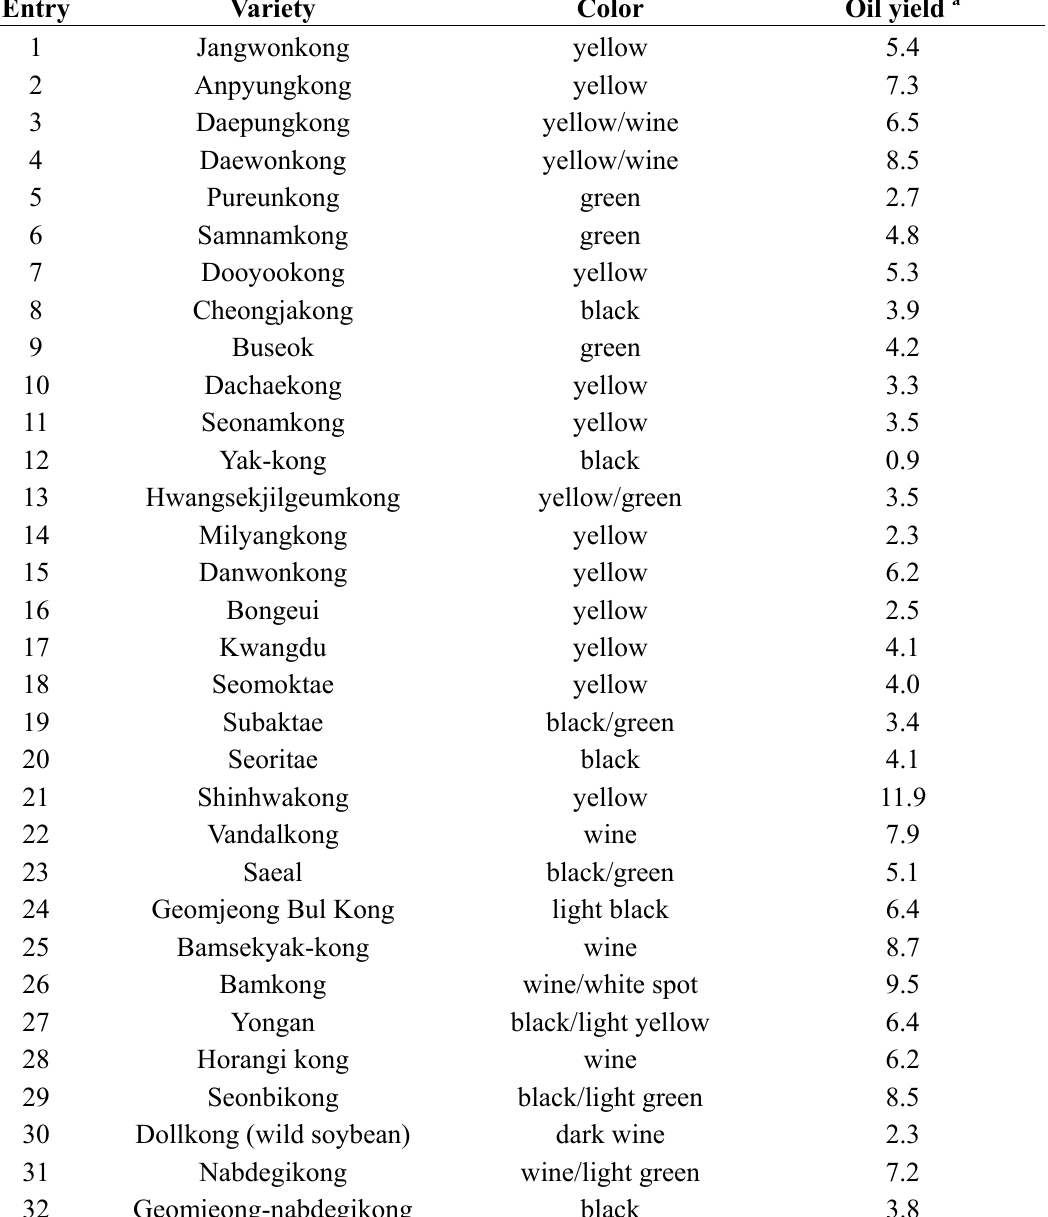
Table 1. Seed color and oil yield of 32 soybean